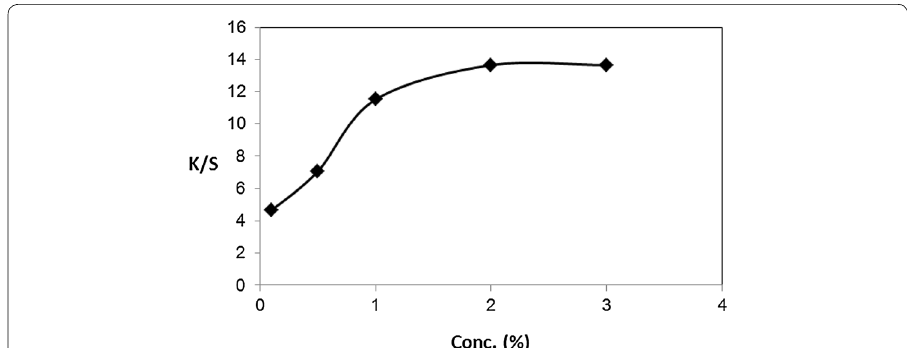
Fig. 4 Color strength depending on the concentration of persimmon peel extract